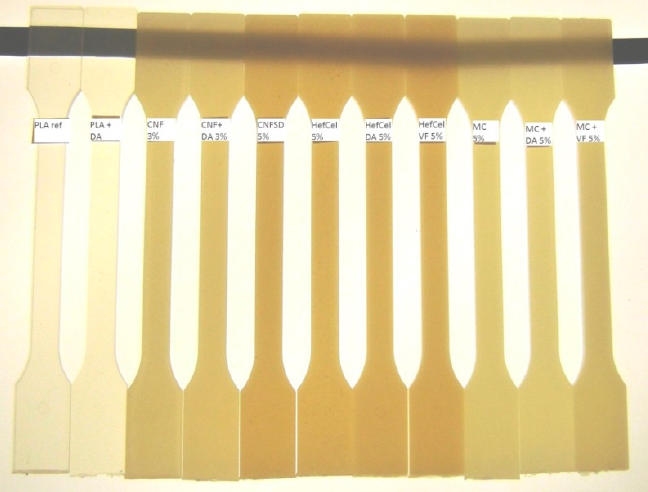
Figure 3. Injection molded test bars.